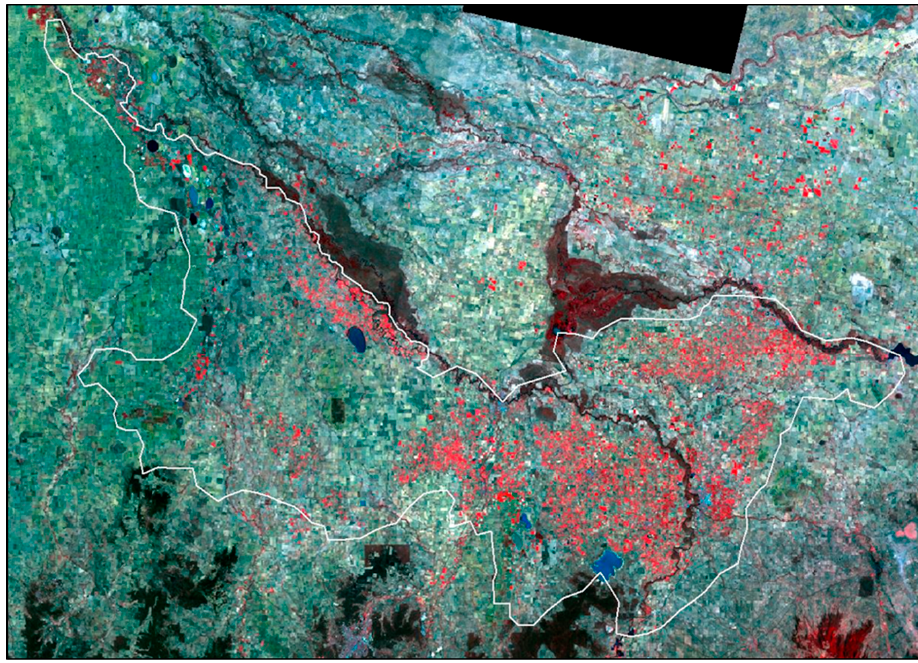
Figure 2. Landsat ‐ 8 satellite of summer 2018–2019 is a mosaic of four scenes acquired during January– February 2019 with the band combination of 543 (Red, Green, Blue). White boundary indicates the extent of the study area.